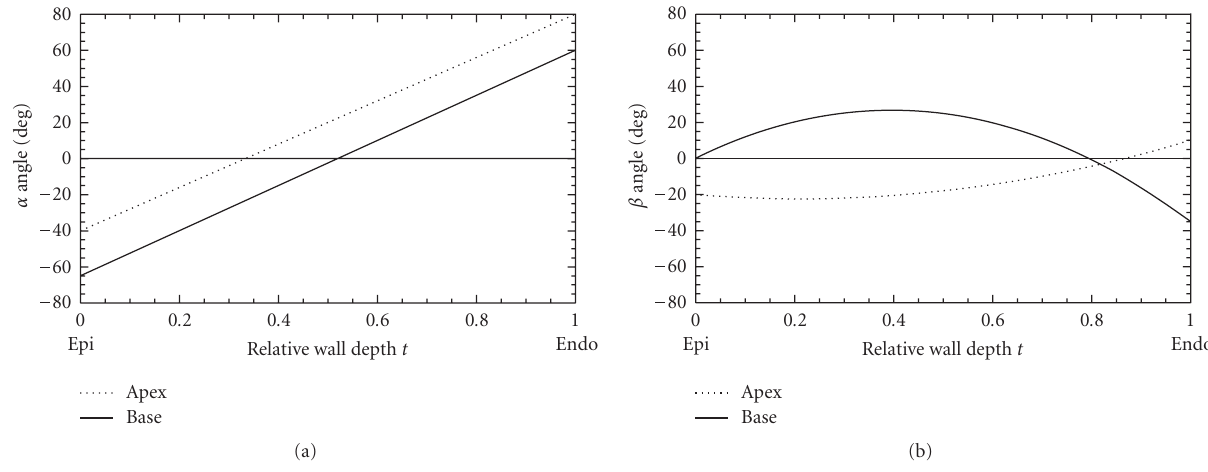
Figure 3: Mathematical approximation of the myofiber architecture at basal (solid line) and apical (dotted line) sites of left ventricle model. (a) Linear transmural distribution of fiber angle α ; (b) quadratic transmural distribution of sheet angle β .